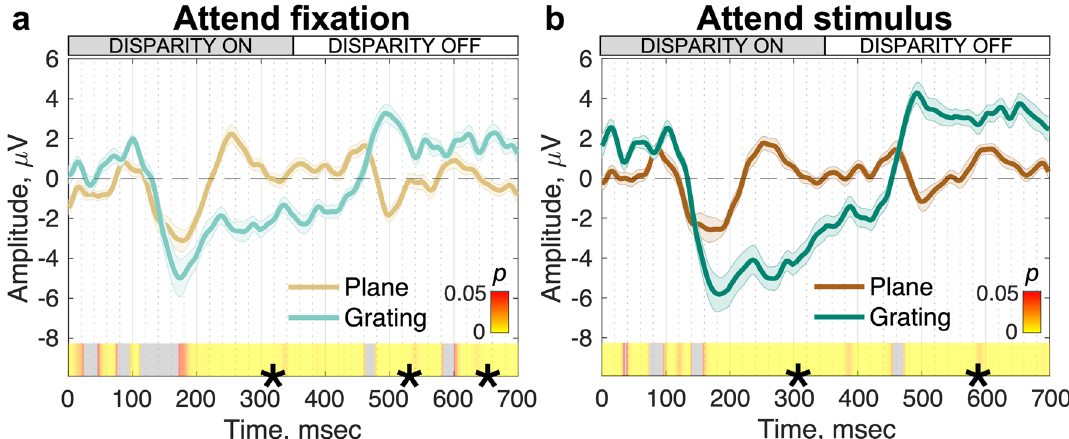
Figure 3. Cycle averages of VEP responses to disparity changes for plane and grating stimuli under ‘attend fixation’ ( a ) and ‘attend stimulus’ ( b ) task conditions (N = 20). In both panels, VEP waveforms are reconstructed via the nF1 clean filter and are weighted by the first reliable component (topographies in Fig. 2). Waveforms are group-level mean responses to a single stimulus cycle consisting of one ‘disparity on’ transition at 0 ms and a ‘disparity off’ transition at ~ 357 ms. Errors are ± 1 SEM. The heat bar indicates the p-value significance of the plane (brown colors) vs. grating (green colors) responses calculated via permutation-based paired t -tests. Segments marked with (*) indicate sequential, significant time points that pass the threshold for run-length correction and grey = nonsignificant.